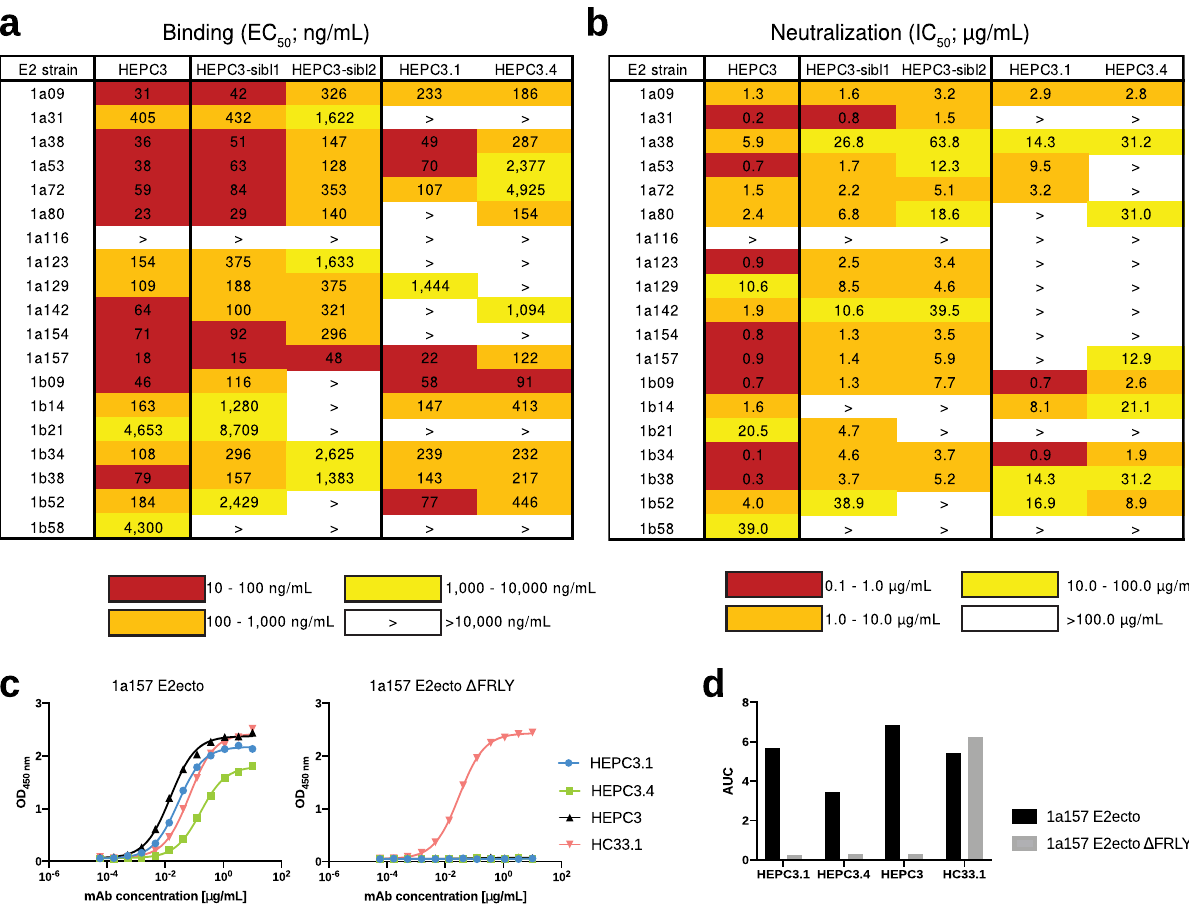
Abs . The Ab HCDR3 loops interact with E2 mostly through backbone-backbone interactions of the β -hairpin at the tip of the loop. These interactions are supported by side chain – side chain and side chain – backbone interactions (Fig. 4d – i). The R/K-Y-C- G-G-G-X-C HCDR3 motif has been suggested to be important for E2 recognition 25 . While there is no doubt of the critical role of the two cysteines and two middle glycines (C-X-G-G-X-C motif) for formation of the observed β -hairpin, the residue after the fi rst cysteine may not be required to be glycine, as observed in HC11, AR3A, AR3X, and the newly described HEPC3-sibl1, HEPC3- sibl2, HEPC3.1, and HEPC3.4. The positively charged amino acid in the − 2 position from the fi rst cysteine is not present in HC11, and the lysine residue in HEPC74 seems not to be involved in the interaction with the antigen. The residue preceding the fi rst cysteine does not interact with the antigen and most likely par- ticipates in overall loop stabilization and positioning. Amino acids in addition to tyrosine are now also found in that position.